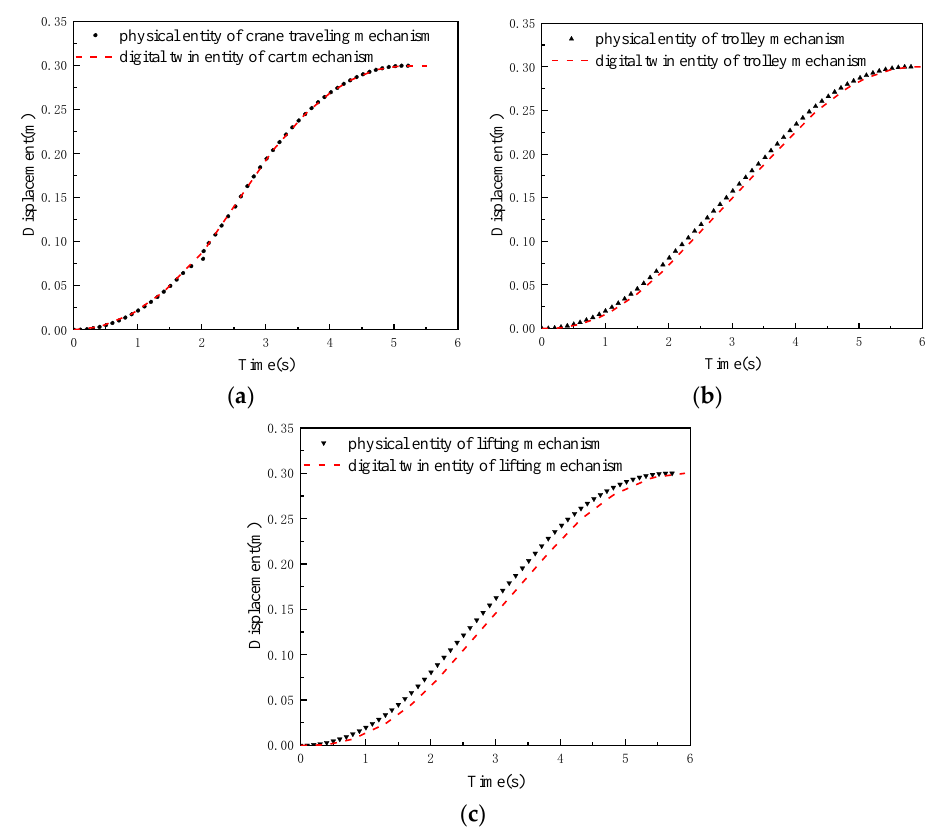
Figure 9. Experimental results of virtual and real displacement consistency: ( a ) crane traveling mechanism; ( b ) trolley mechanism; ( c ) hoisting mechanism.